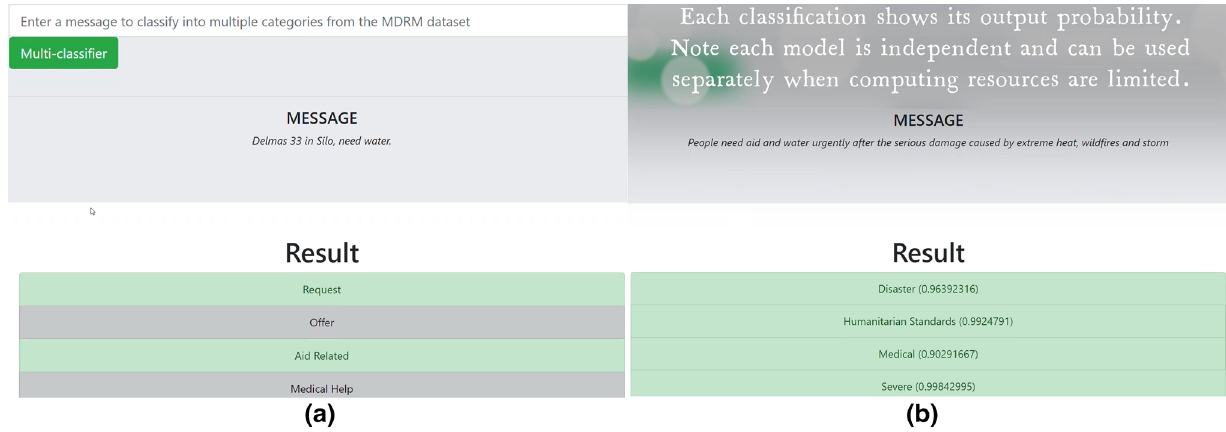
Fig. 4 Examples of ( a ) multiclass classification and ( b ) binary classification for test input